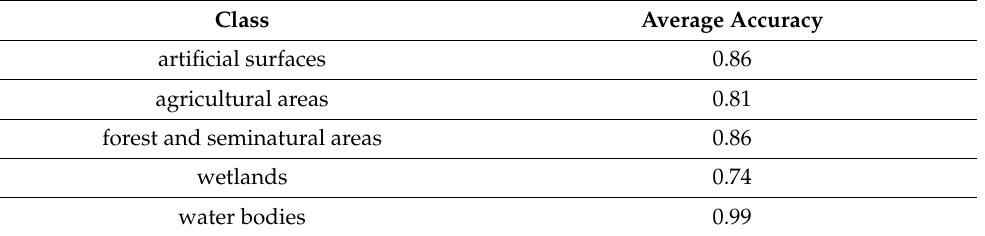
Table 2. Accuracy assessment of the LULC classification for the Hanoi Province for each class over the different